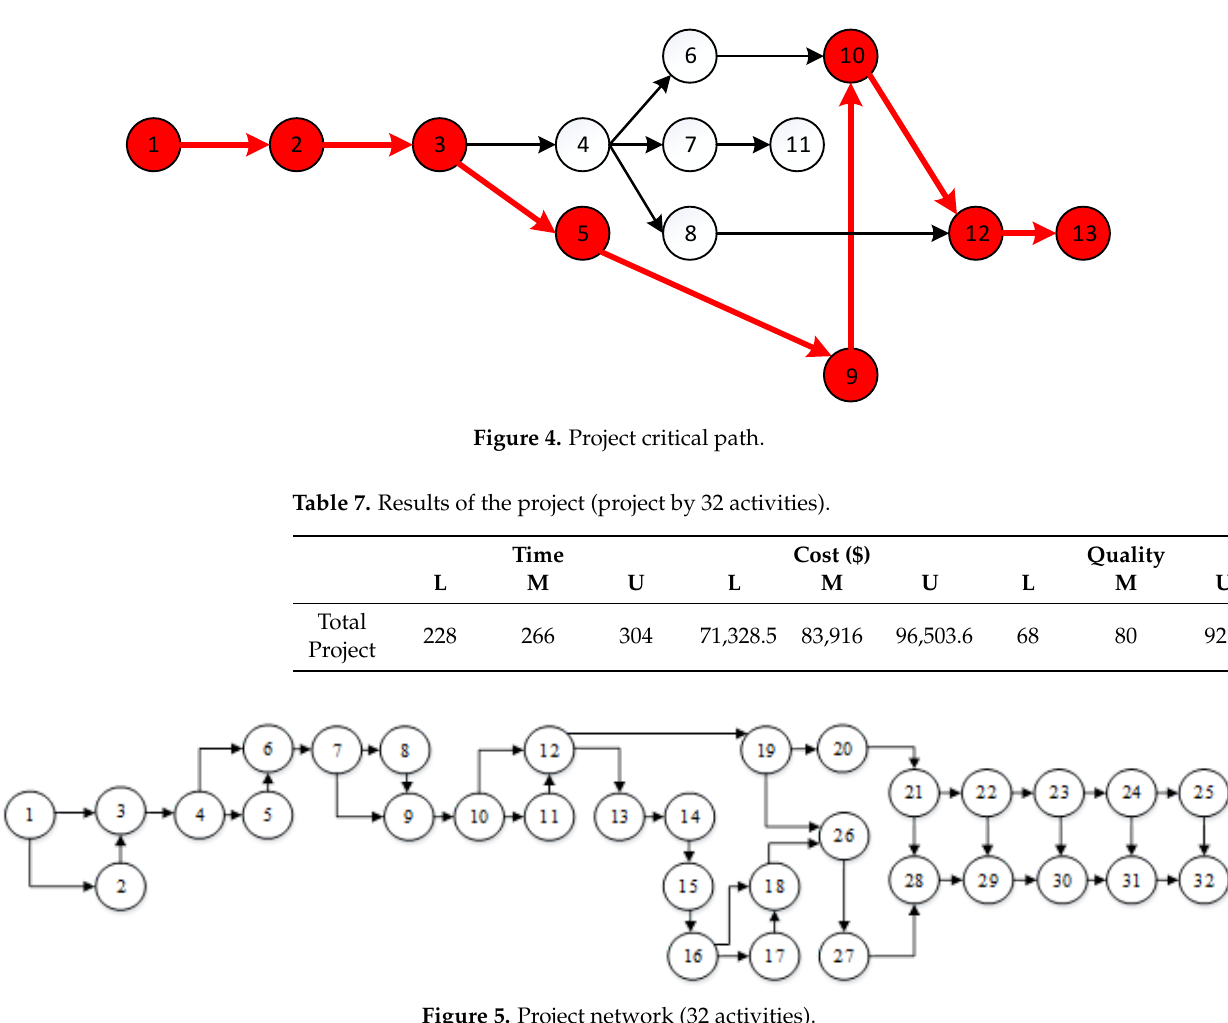
Table 7. Results of the project (project by 32 activities).